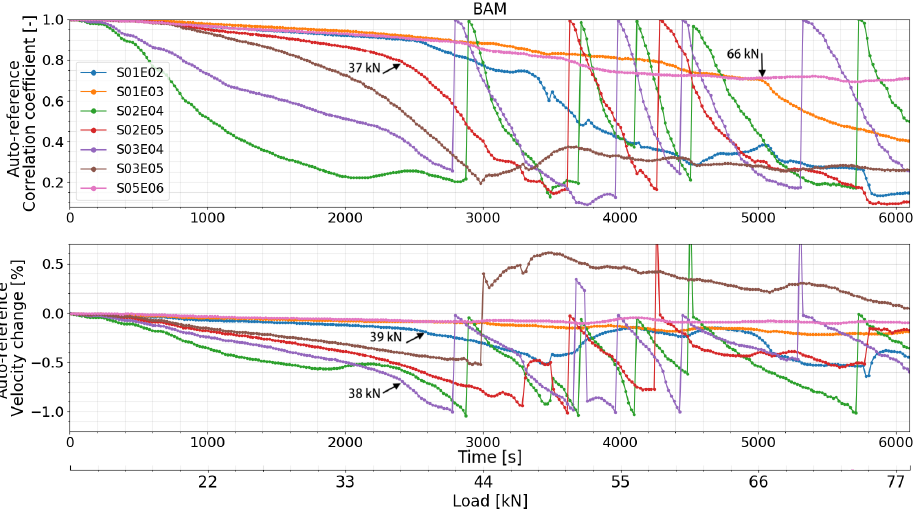
Figure 16. Correlation coefficient and relative velocity change of all the transducers combinations in test at BAM calculated by auto reference